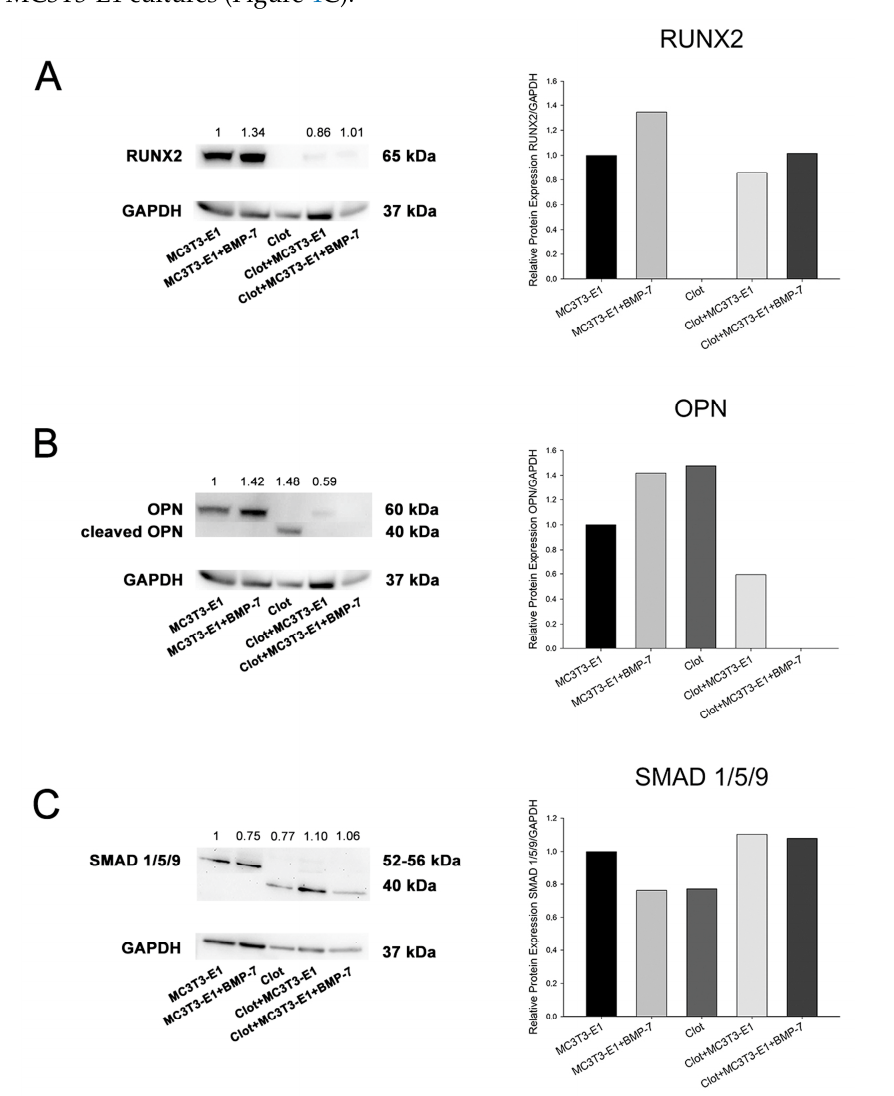
Figure 4. Detection and quantification of RUNX2 ( A ), OPN ( B ), and phosphorylated-SMAD 1/5/9 ( C ) by Western blotting (number of pixels of the protein bands normalized to GAPDH) in MC3T3-E1 cell cultures grown for 5 days and in blood clots on time 0 on Nano-Ti surfaces either functionalized with or without rmBMP-7. The bars represent one biological replicate (resulting from the pooling of 20 independent wells/experimental replicates for each group) and one technical replicate. The ratio of the control group (MC3T3-E1) is assigned a value of 1. Lower molecular weight bands in ( B , C ) are cropped to fi t the fi gure.